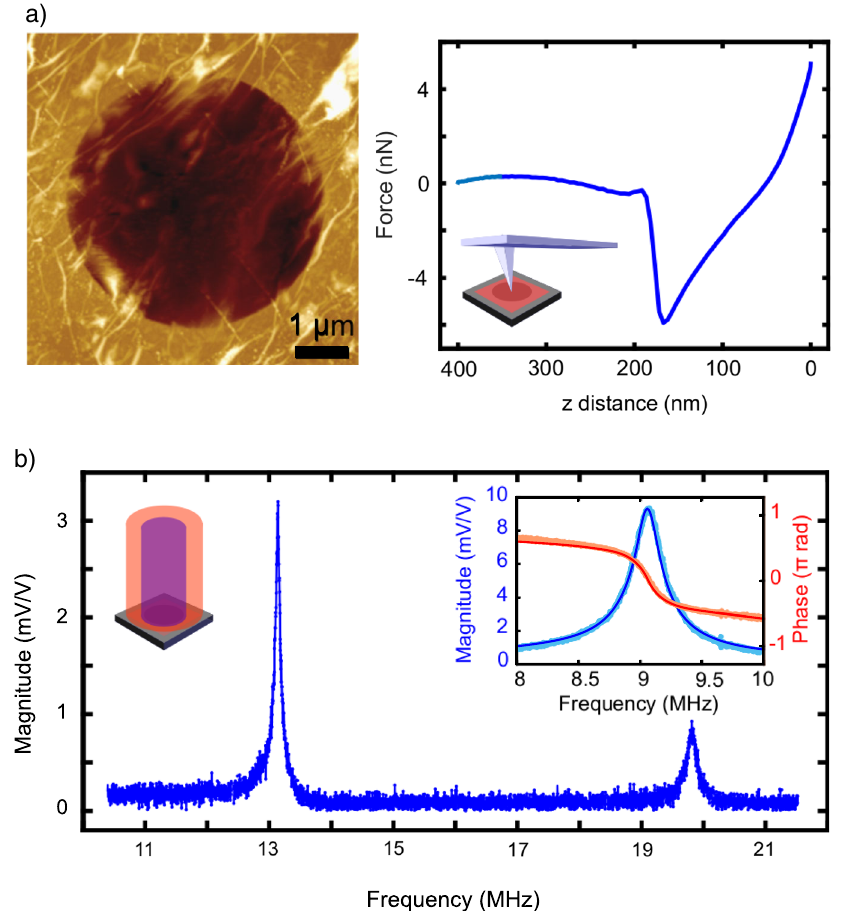
Fig. 3 Characterization of h-BN 5 µm in diameter drums. a AFM image of the h-BN drum showed in Fig. 1b. The CVD material shows wrinkles and sidewall adhesion as in CVD graphene ( left panel ). The force distance curve in the center of the drum is obtained by AFM indentation in Peak Force mode. From the retraction curve we extract the tension and Young ’ s modulus. b Mechanical frequency spectrum of the same drum at room temperature and ~10 − 6 mbar when measured with the optical interferometric technique after cleaning. The second resonance peak appears around 1.5 times the fundamental frequency, indicating membrane behavior. 37 Inset Mechanical fundamental frequency and phase analysis of the same drum before cleaning. By fi tting the frequency peak to the driven harmonic oscillator equation, we extract the tension